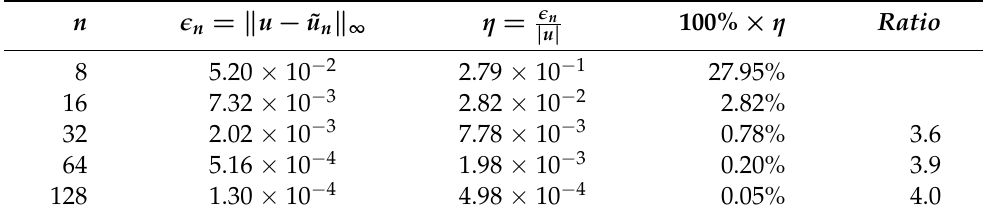
Table 10. IE (50), λ A = − 0.5, c = 0.1. QM: Trapezoidal